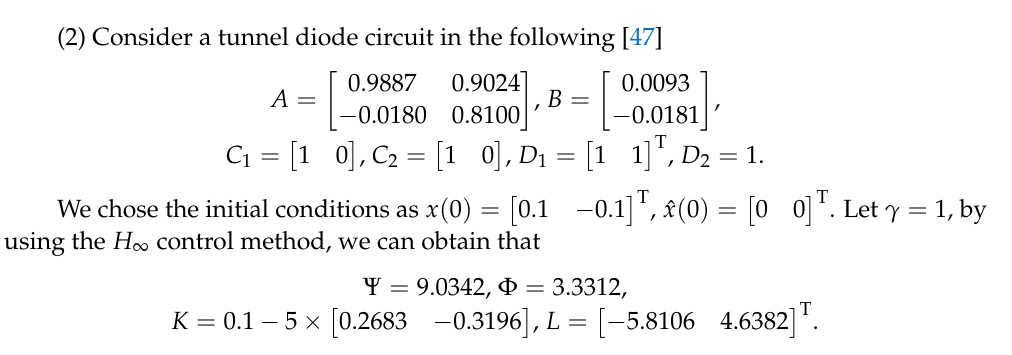
Figure 4. Times of DoS jamming attacks.